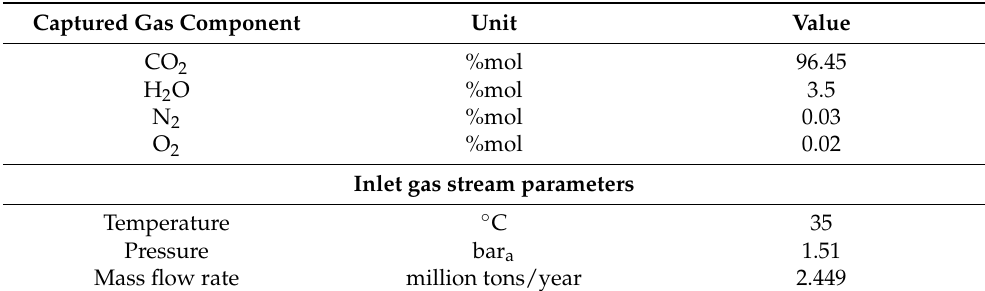
Table 3. Molar concentrations of individual components of the captured gas and inlet flow parameters are assumed for design purposes.